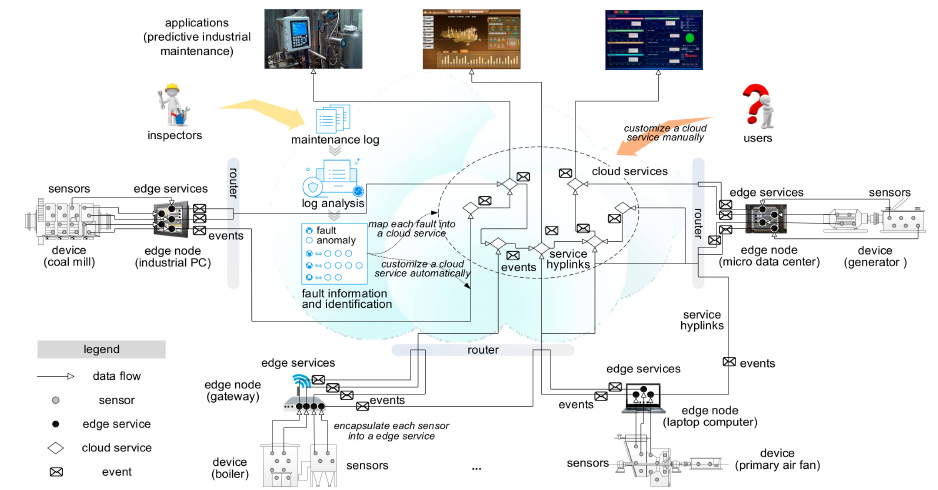
Figure 2. The framework of our approach.